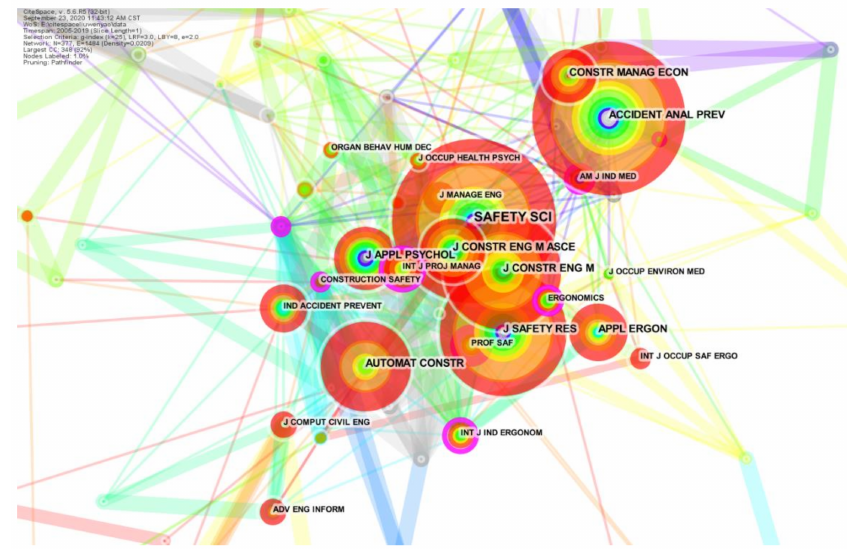
Figure 3. The result of literature publication source